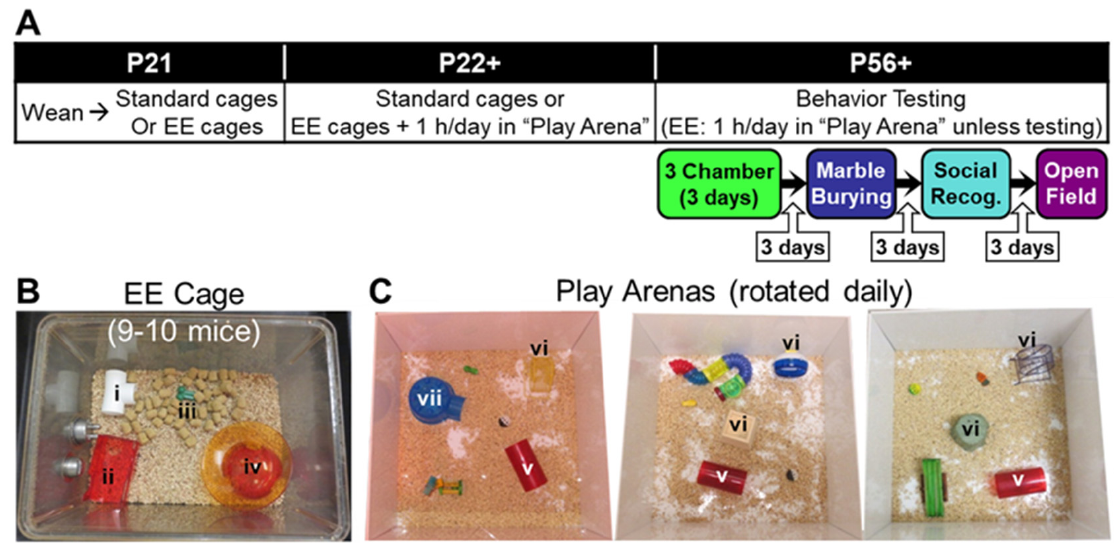
Figure 1. Experimental design. ( A ) Timeline from beginning of environmental enrichment (EE) to end of testing. ( B ) EE cage. ( C ) Play arenas with the three different toy groups. EE mice received 1 h in the play arena on every day they were not behaviorally tested from weaning. i, White t-shaped tube; ii, red two-level house; iii, green chew toy; iv, igloo-style hut with saucer running wheel; v, large red tube; vi, running wheel; vii, shelter.